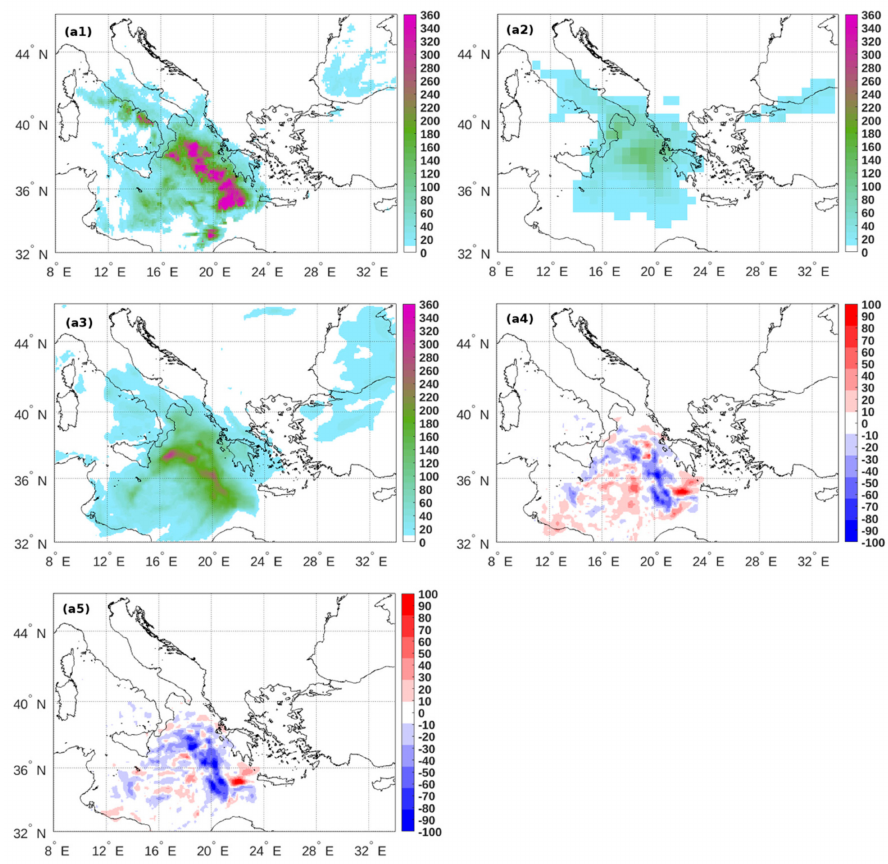
Figure 15. ( a1 ) Accumulated precipitation field in millimeters from IMERG satellite data, ( a2 ) accumulated precipitation field in millimeters from MERRA-2 reanalysis ( a3 ) accumulated precipitation in millimeters field from RTG-sst run ( a4 ) di ff erences in accumulated precipitation fields between NEMO-sst and RTG-sst, and ( a5 ) di ff erences in accumulated precipitation fields between OSTIA-sst and RTG-sst, for cyclone